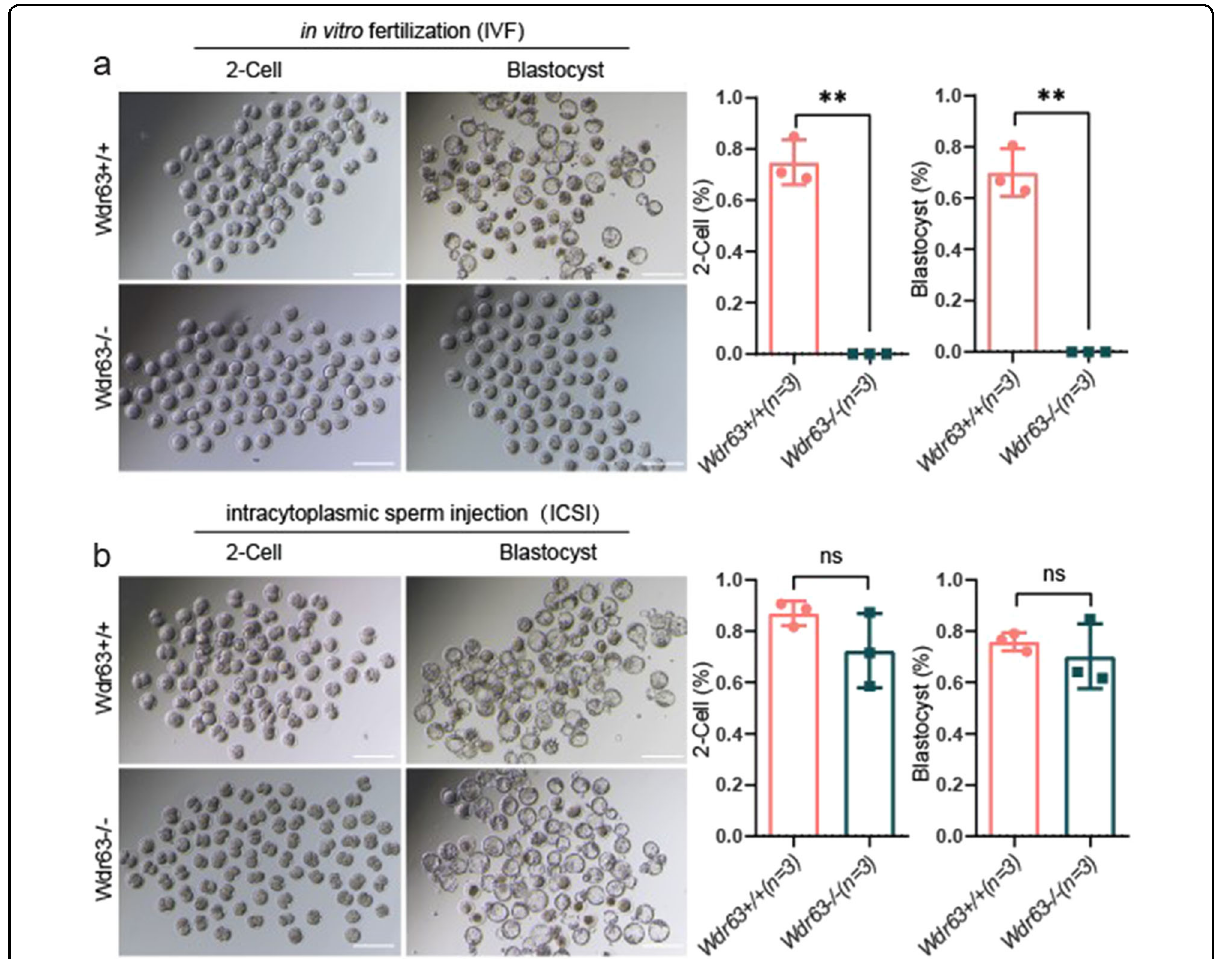
Fig. 6 WDR63-associated male infertility could be rescue by ICSI but not IVF. a Representative two-cell embryos and blastocysts from in vitro fertilization. Scale bar, 200 μ m. Compared with WT male mice, the rates of 2-cell and blastocyst as lower as zero in Wdr63 KO male mice. b Representative two-cell embryos and blastocysts from intracytoplasmic sperm injection. The 2-cell and blastocyst were successfully obtained upon ICSI using the spermatozoa from Wdr63 KO male mice. Scale bar, 200 μ m. For a and b , n = 3 and the bars represent means ± SEM. The statistical analysis was carried out using One-way ANOVA test, ** denotes P < 0.01; ns, not signi fi